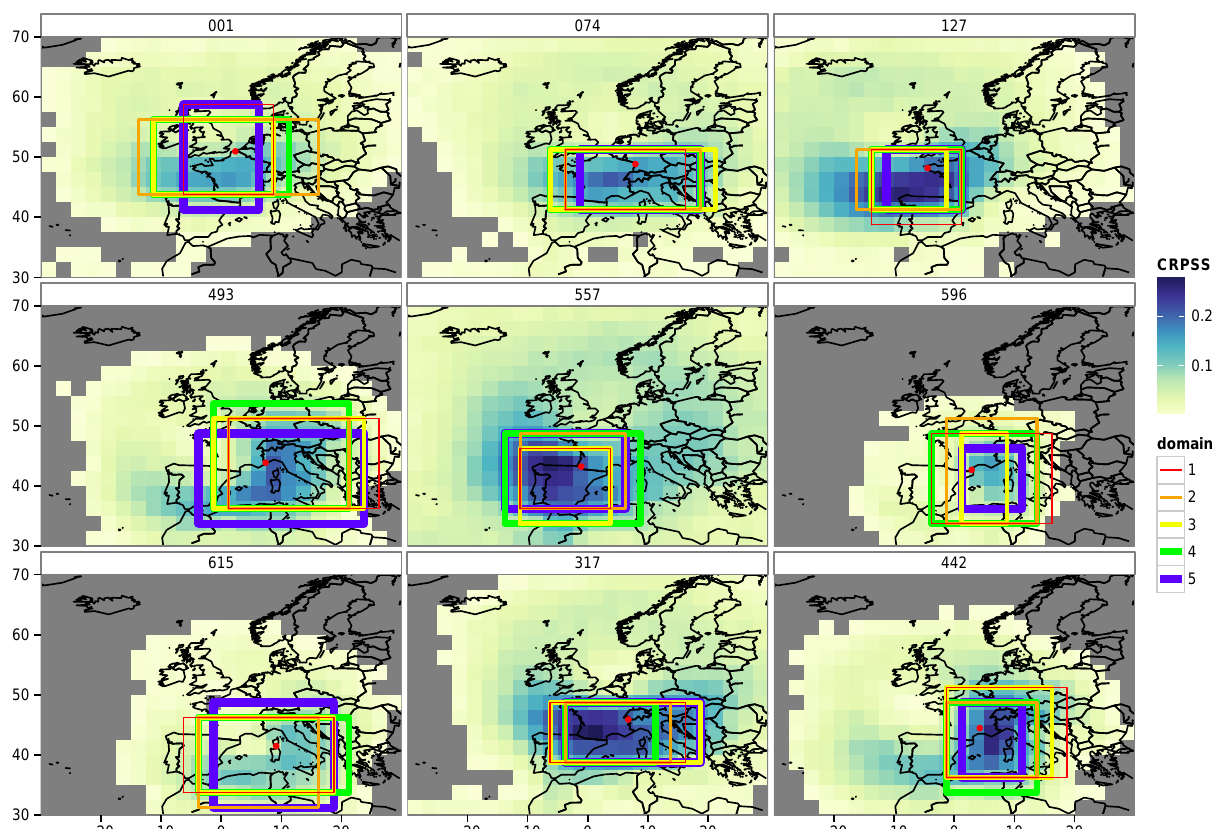
Fig. 3. Relevance maps truncated at CRPSS=0 (areas with higher skill than the climatology) and optimised domains for nine zones identified in Fig. 1 using the 20yr archive. The best domain found is drawn in red, followed then by those in orange, yellow, green and blue. The zone location is indicated by a red dot.